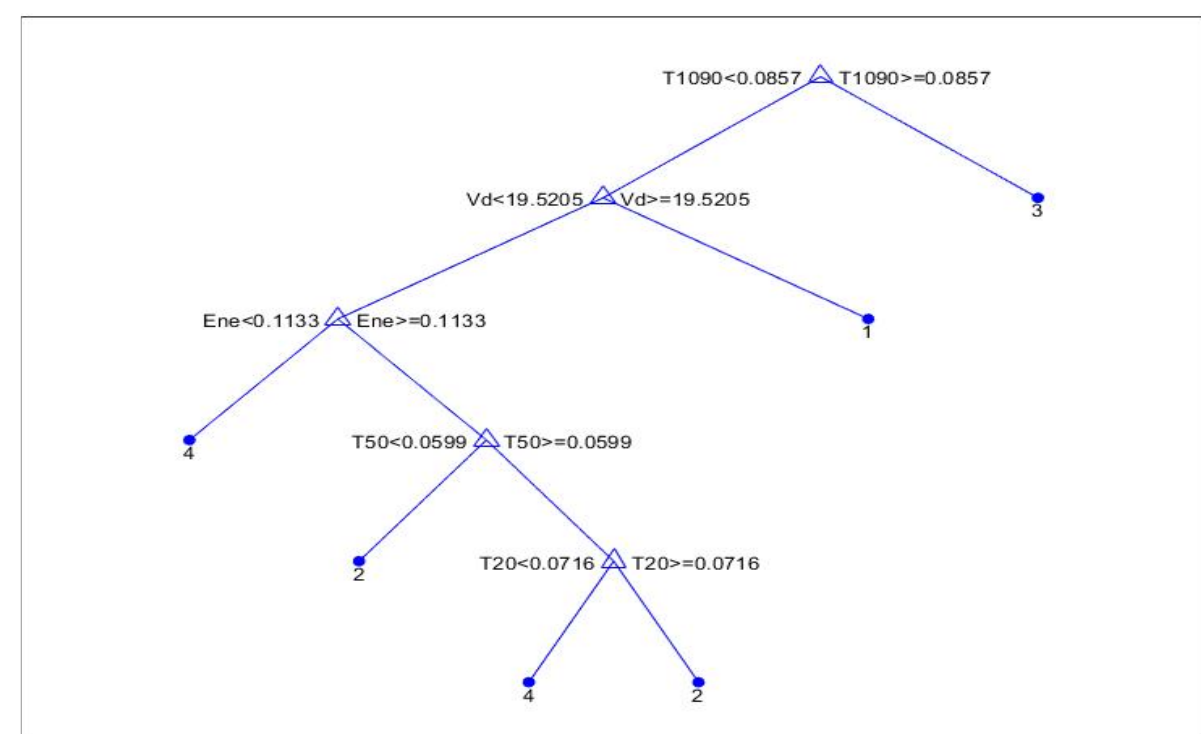
Figure 16. Decision tree diagram of fault causes without cross-validated.